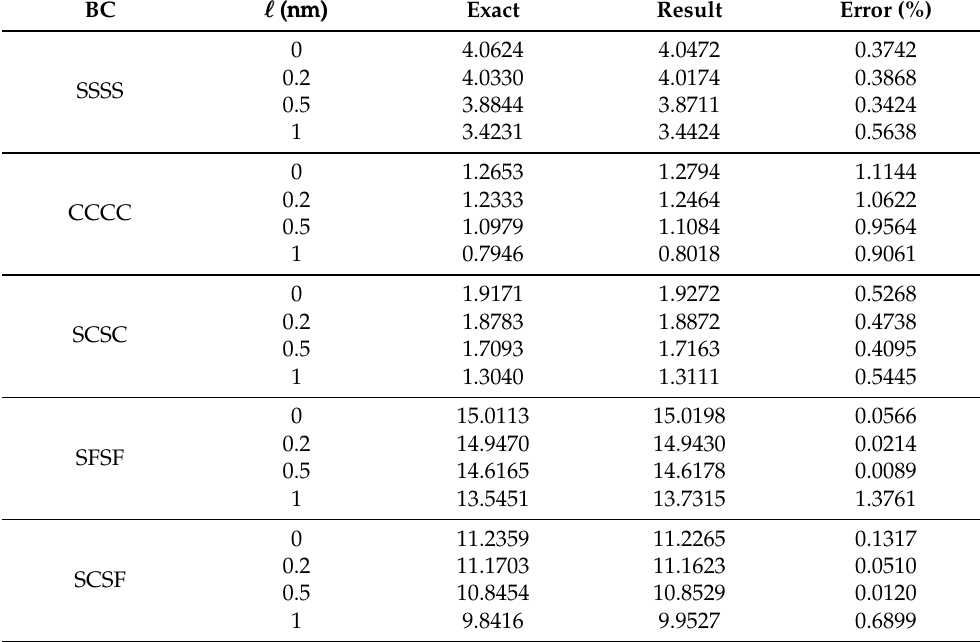
Table 6. Values of ¯ w for 11 × 11 nodal distribution, obtained for α C = 1.06, q = 1.3, α s = 2.3.